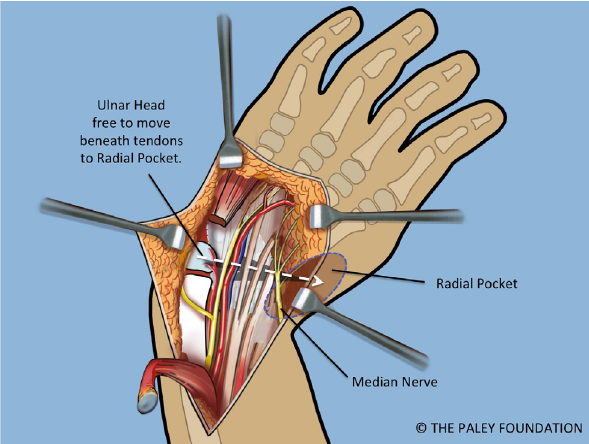
Figure 11. A space is made radial to the carpus, called the radial